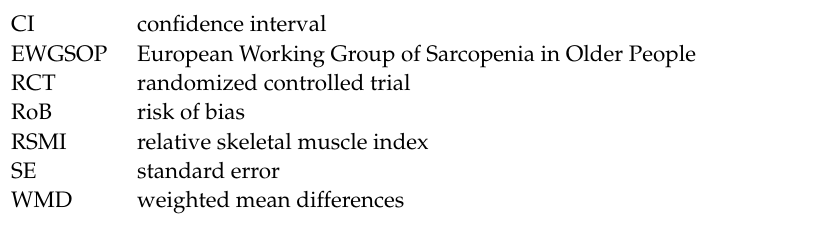
relative skeletal muscle index, Figure S4: Funnel plot of body fat